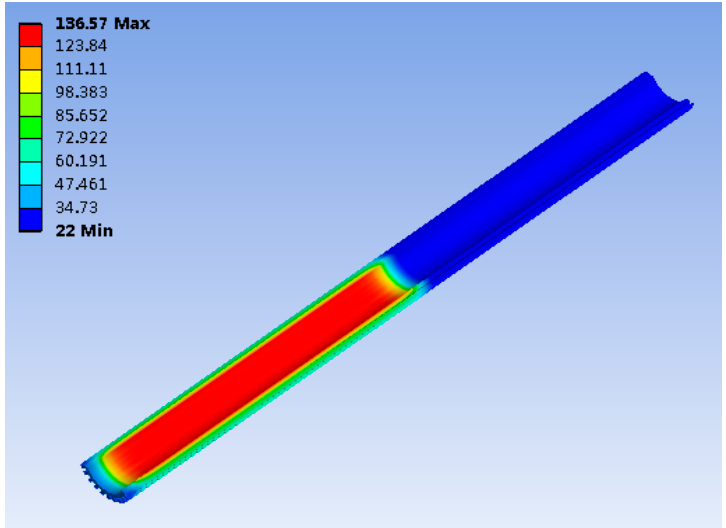
Figure 8. Temperature distribution of the optimized collector.